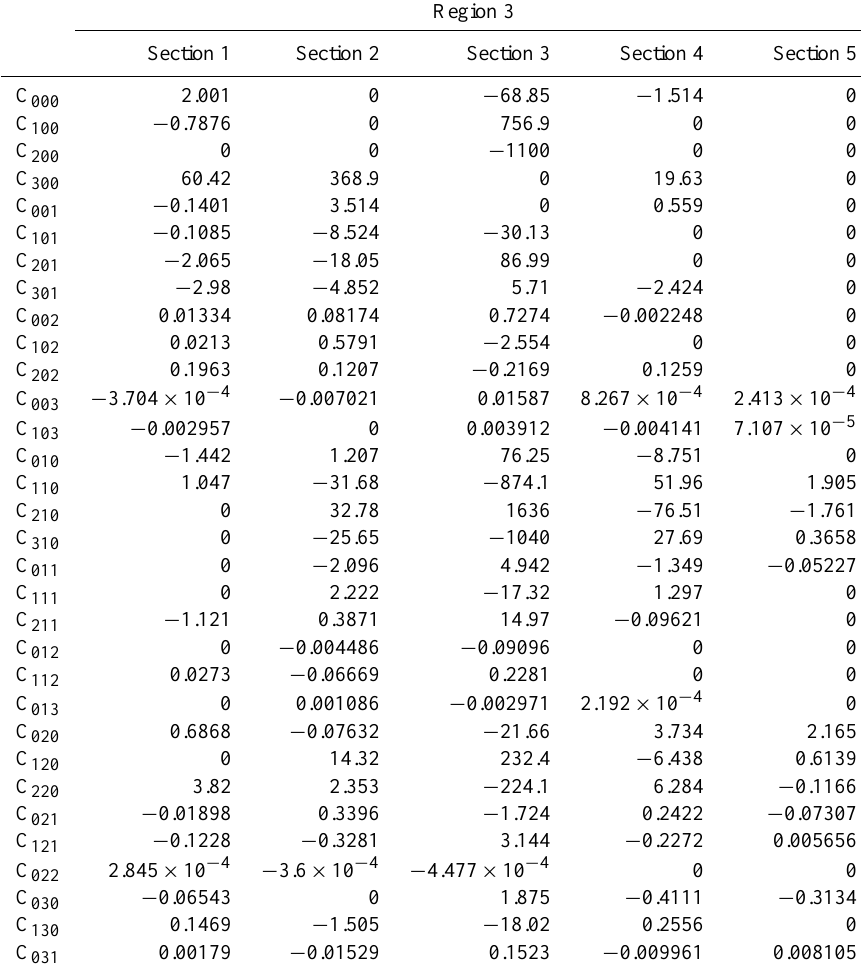
Table 5. Similar to Table 3, but for region